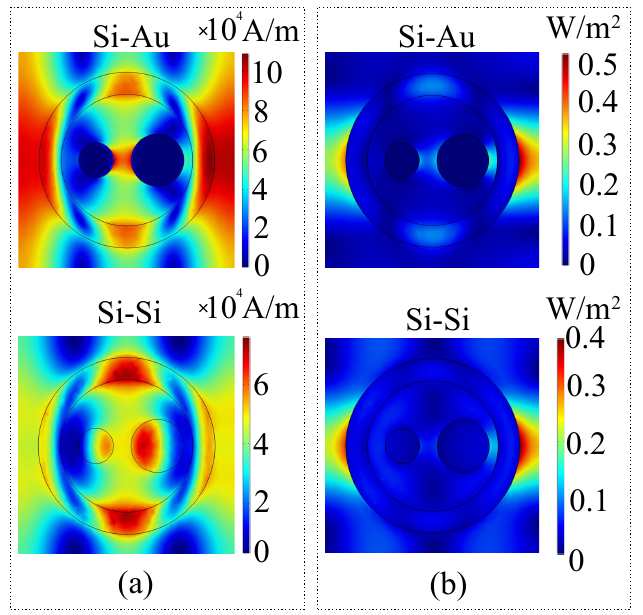
Figure 7. ( a ) Magnetic field and ( b ) average power flow of the wave induced by the metasurface elements in the gold-silicon and all-silicon